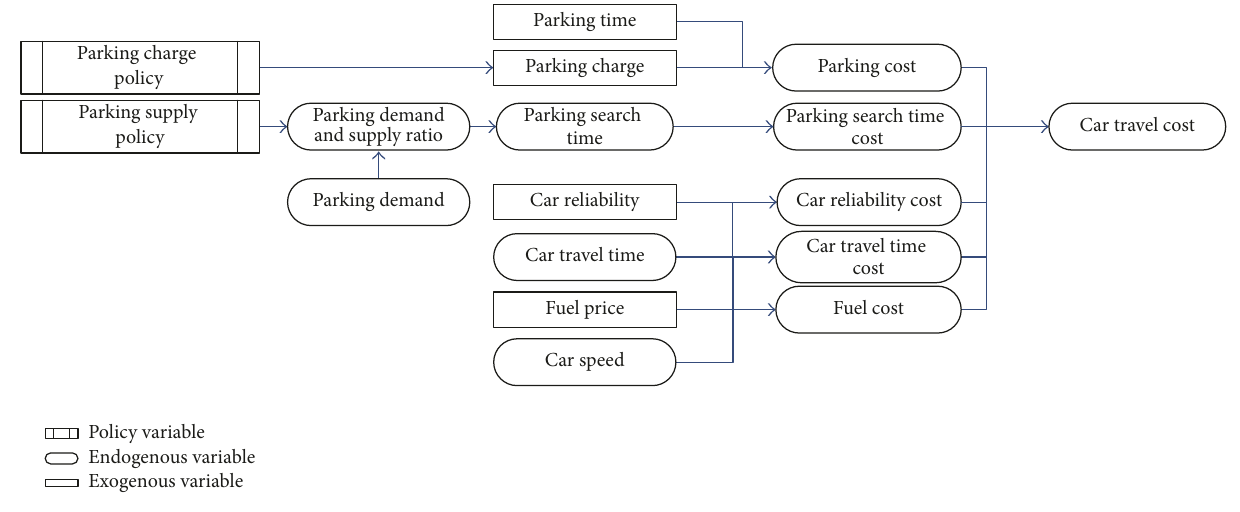
Figure 2: Subsystem for estimating car travel cost.